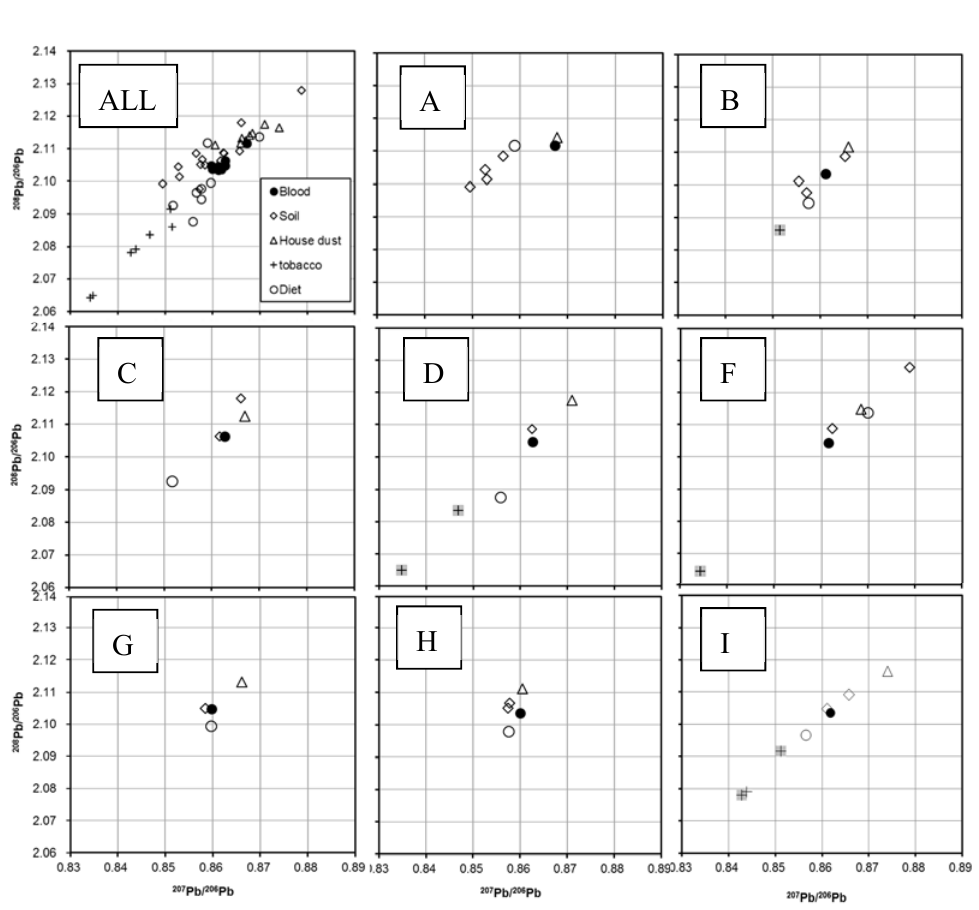
Figure 1. Lead isotope ratios ( 207 Pb/ 206 Pb, 208 Pb/ 206 Pb) of all subjects (ALL) and of individual subjects (A–I).